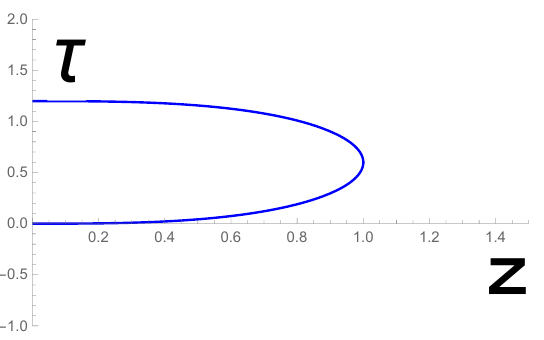
Figure 8 . The profile of EOW brane with brane-localized scalar source, which may be called bound- ary Janus. The horizontal and vertical axis describe z and τ , respectively. In this plot we set z 0 = 1 .